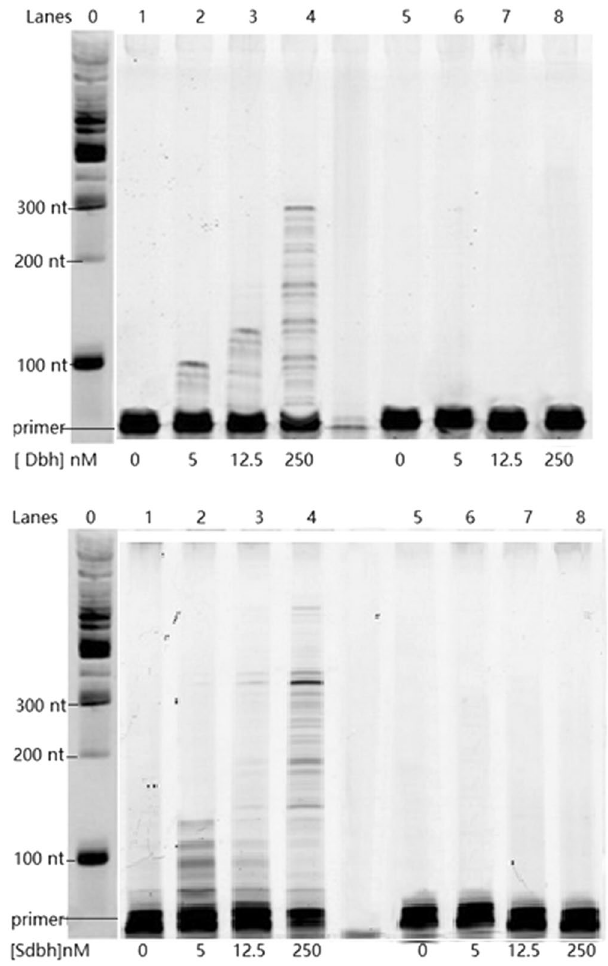
Figure 2. Processivity of Dbh and Sdbh. The ability of Dbh and Sdbh to extend a FAM-labeled primer (FAM- 36 primer) annealed to single-stranded M13mp18 DNA from a single DNA binding event in the presence of a DNA trap. In lanes 1–4, the pol was preincubated with the primer-template DNA (12.5 nM) and the reactions were initiated by the addition of dNTPs (200 μ M) and excess sperm DNA trap. As a control (lanes 5–8), the pol was preincubated with the primer-template DNA and the herring sperm DNA trap, and reactions were initiated by the addition of dNTPs. The intensity along the length of the lane was quantified and then the marker standards were used to assign a basepair length through the lanes using ImageQuant software. From there the greatest abundant product could be measured as the processivity. The unlabeled marker standards were visualized by SYBR stain independently and showed the length (nt) on the left of the first lane. (Note: the synthesized primer was 36 nt, but the FAM label altered its electrophoretic mobility, such that it ran at about 80 nt). See Supplemental S1 for full-length